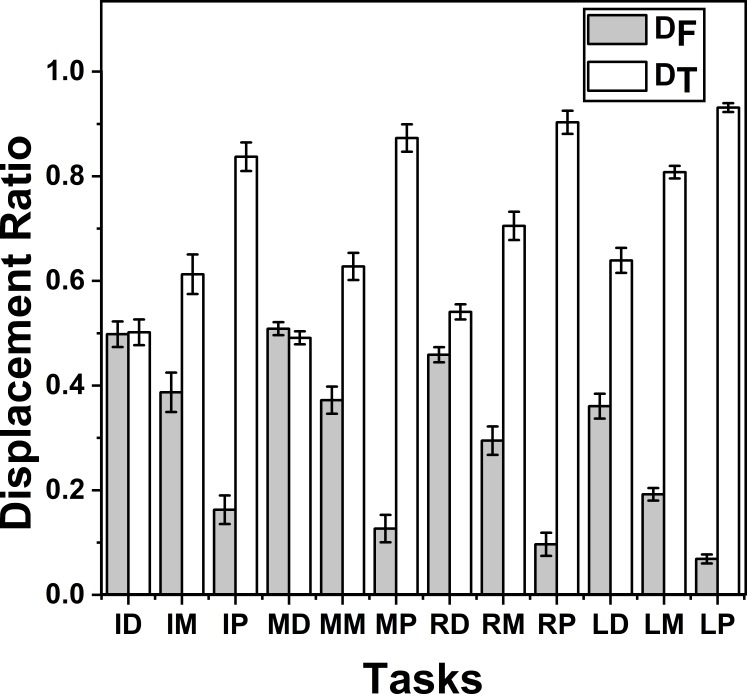
Change of Displacement Ratio for different task.The x-axis indicates different target positions. I, M, R, and L denote the Index, Middle, Ring and Little fingers, respectively. Similarly, P, M, D denote Proximal, Middle and Distal phalanges respectively. DT was significantly (p < 0.001) greater than DF in all the tasks except in the task involving the distal phalanx of the index (ID) and middle (MD) fingers. There was no significant difference between DT and DF in these tasks (ID and MD). The columns and bars indicate means and standard error of means.